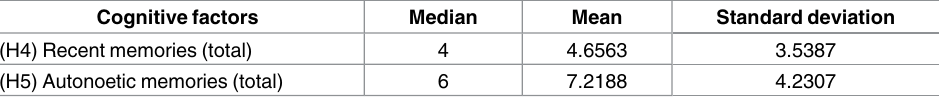
Table 2. Cognitive factors and median, mean, and standard deviation of the number of mentions in free lists applied to informants in the community of Car ã o, state of Pernambuco (northeastern Bra- zil), between February and October of 2015. H = hypothesis